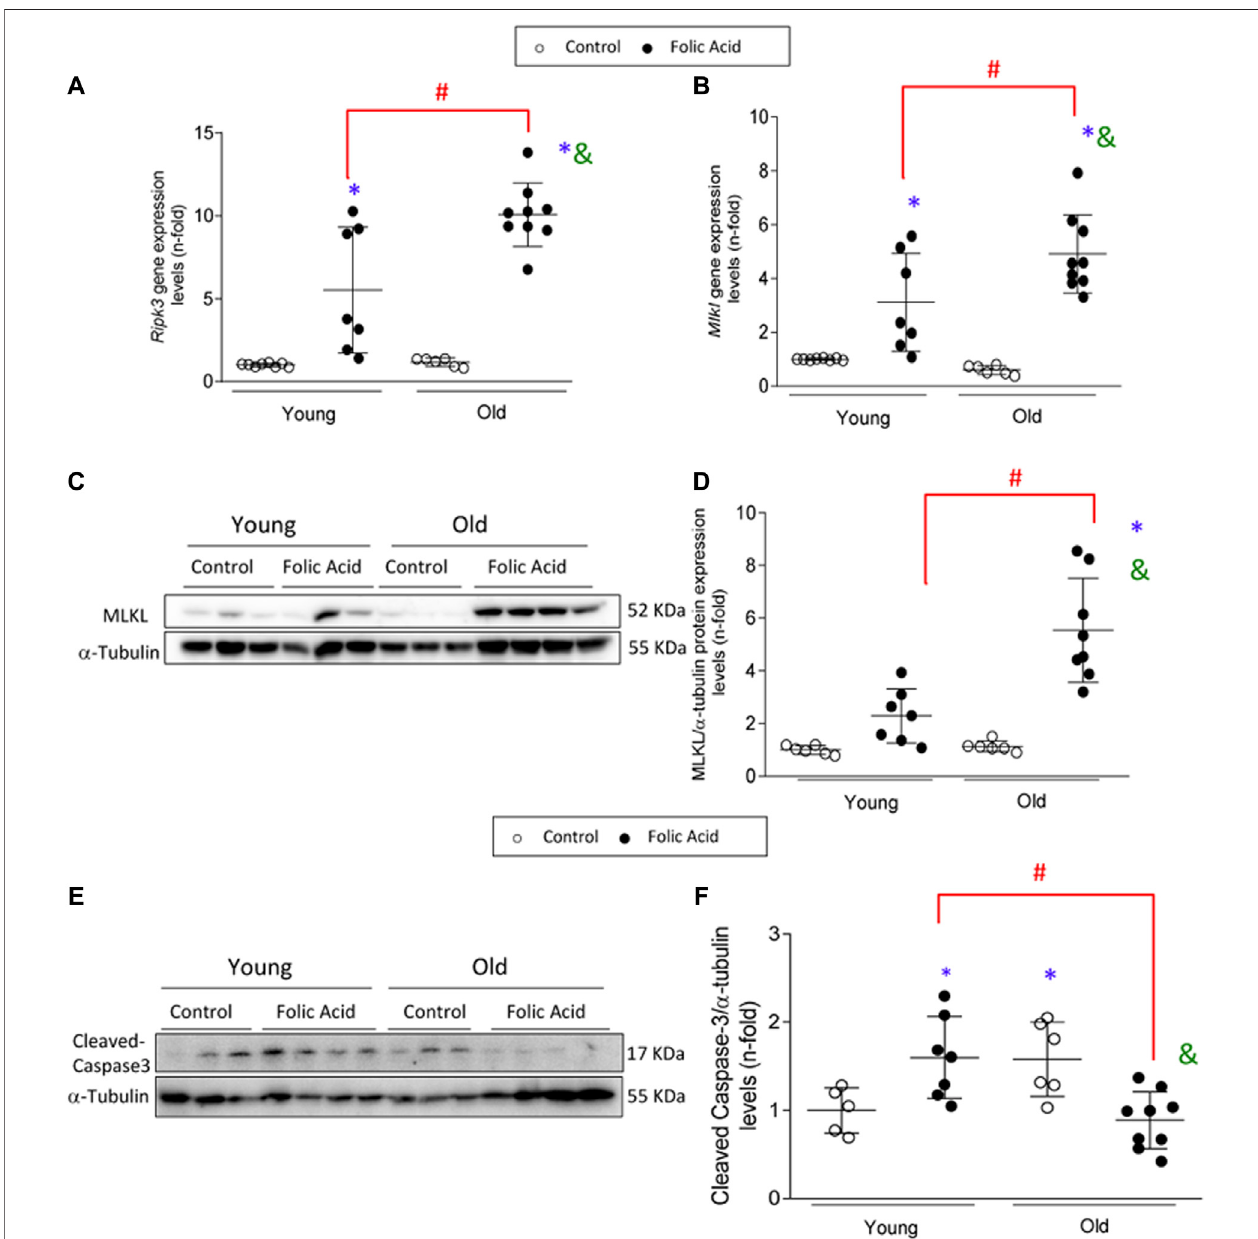
FIGURE 6 | Upregulation of the necroptosis pathway in the acute phase of folic acid (FA) nephropathy in old and young mice. Folic Acid (FA; 125 mg/kg) was injectedin3-months-old(Young)and1-year-old(Old)C57BL/6miceandkidneyswerestudiedafter48 h.Therenalgeneexpressionlevelsof Ripk3 (A) and mlkl (B) were evaluatedbyqRT-PCR. (C – F) MLKLproteinandactivecaspase-3(represented bycleavedcaspase-3)weredeterminedbyWesternblot. α -tubulinwasusedasloading control. (C, E) Representative blots and (D, F) their quanti fi cation. Data are shown as n-fold and expressed as mean ± SD of n (cid:2) 5 – 9 animals per group. * p < 0.05 vs. control young mice, # p < 0.05 vs. FA-injected young mice, & p < 0.05 vs. control old mice. The parametric one-way ANOVA statistical test was performed.